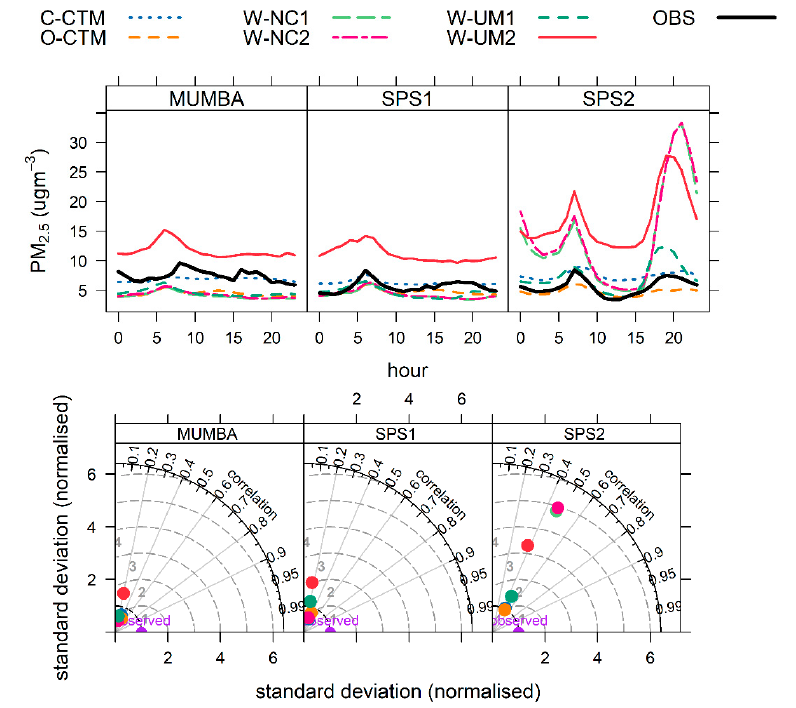
Figure A2. Taylor diagrams for O 3 4 hourly average values for each campaign period (upper panel) and mean bias for paired model / observed O 3 4 hourly average values, split into quantile bins (0–1, 1–5, 5–10, 10–25, 25–50, 50–75, 75–90, 90–95, 95–99 and 99–100 percentiles) for observed values (lower panel).